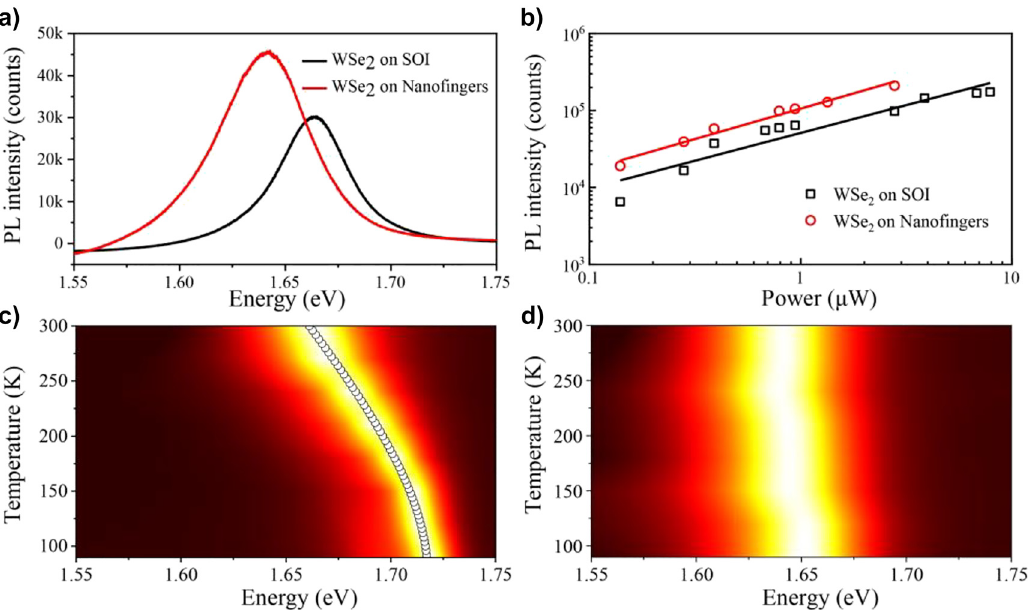
Figure 4: Characterizations of photoluminescence for WSe 2 on SOI and nano fi ngers. (a) PL spectra of monolayer WSe 2 on SOI (black) and nano fi ngers (red) at room temperature. (b) PL peak intensity of WSe 2 on SOI (black) and nano fi ngers (red) with different incident laser power. (c) The measured temperature dependent PL spectra of WSe 2 on SOI (the theoretical fi tting of PL peak marked by hollow circle line). (d) Temperature dependent PL spectra of WSe